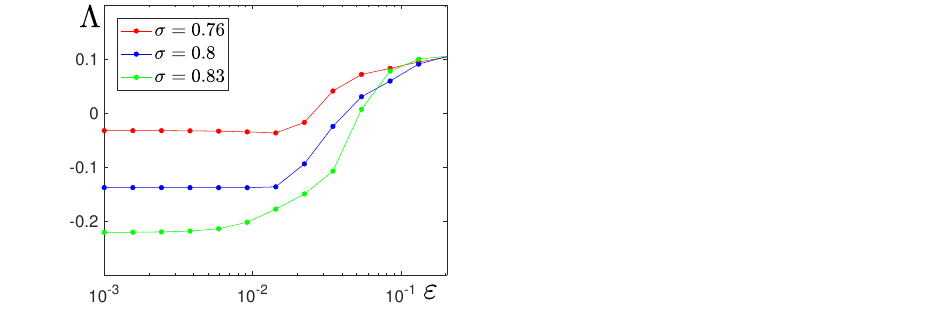
Figure 10. Largest Lyapunov exponent of system (2) versus noise intensity for three different cou- pling